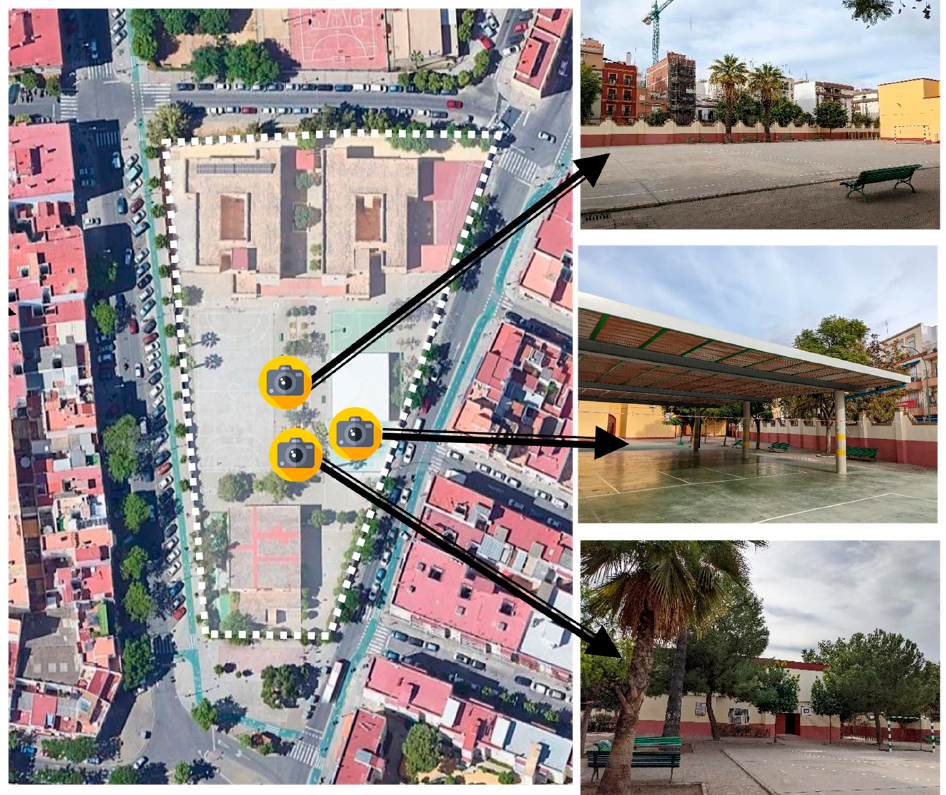
Figure 1. Map of the study area in Seville (Spain).